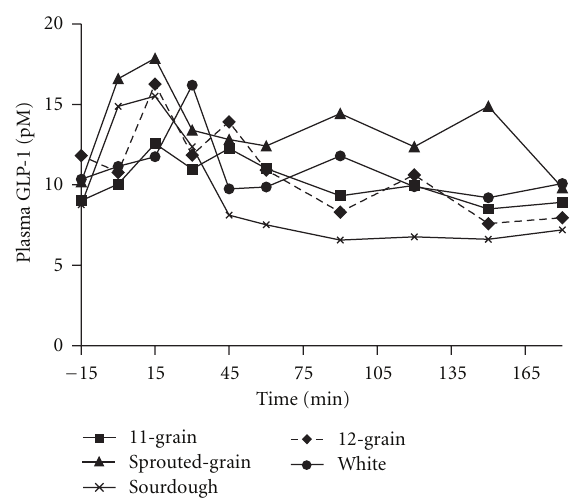
Figure 6: Fasting and postprandial GLP-1 responses to the inges- tion of a consistent amount of the test breads. Data are means. Standard errors are not included for clarity, n = 10. Test bread was ingested after collection of fasting blood sample at time point − 15 min. Significant overall treatment e ff ects were found (sprouted-grain bread was greater than 11-grain ( P < 0 . 008), sourdough ( P < 0 . 001), 12-grain ( P < 0 . 04), and white ( P < 0 . 04)